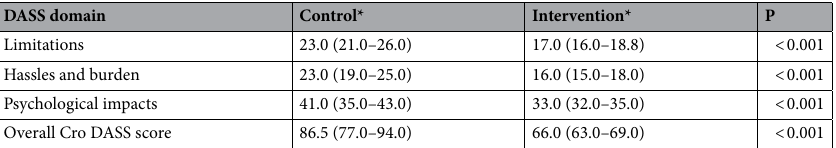
Table 2. Cro-DASS scores at the end of the study period (after six months). *Median score (interquartile range) on scale 25 to 175 scores for overall Cro-DASS, 9 to 63 scores for Limitations domain, 8 to 56 scores for Hassles and burden domain and 8 to 56 scores for Psychological impacts domain; lower scores indicating a better quality of life. P value calculated using the Mann–Whitney U test.